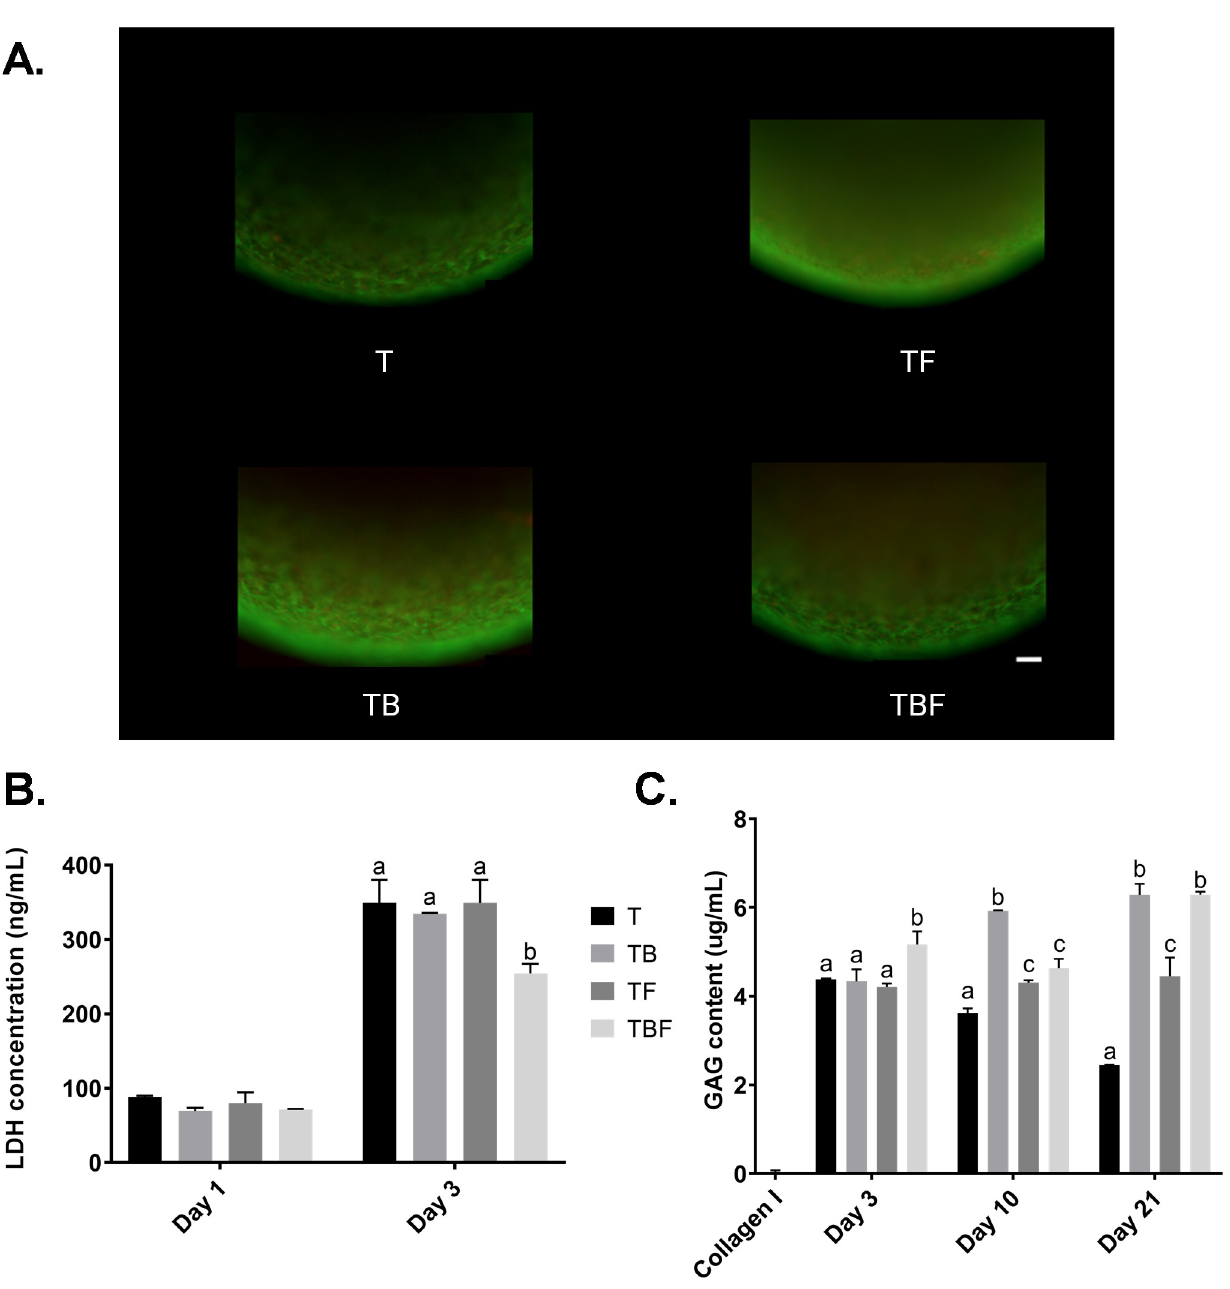
Fig 6. Cytotoxicity and total glycosaminoglycan (GAG) content. Constructs were fabricated as described in Fig 2B and cultured for up to 21 days. A) At day 3, constructs were assessed for cytotoxicity using live/dead staining with calcein (green, live) and propidium iodide (red, dead). While occasional dead cells were identified, the vast majority of cells were viable. Bar = 100 μ m. B) Conditioned media were collected at day 1 and at day 3 to assess cytotoxicity using the lactate dehydrogenase (LDH) assay. At day 1 (24 hours conditioning), significant differences were not detected between treatment groups. At day 3 (48 hours conditioning), LDH concentrations were higher than day 1 in all groups. Treatment group TBF had a lower LDH concentration than other groups. C) Constructs were digested in papain solution prior to assessment of total GAG content at day 3, 10, and 21. Constructs cultured with BMP-2 and/or bFGF exhibited the highest total GAG